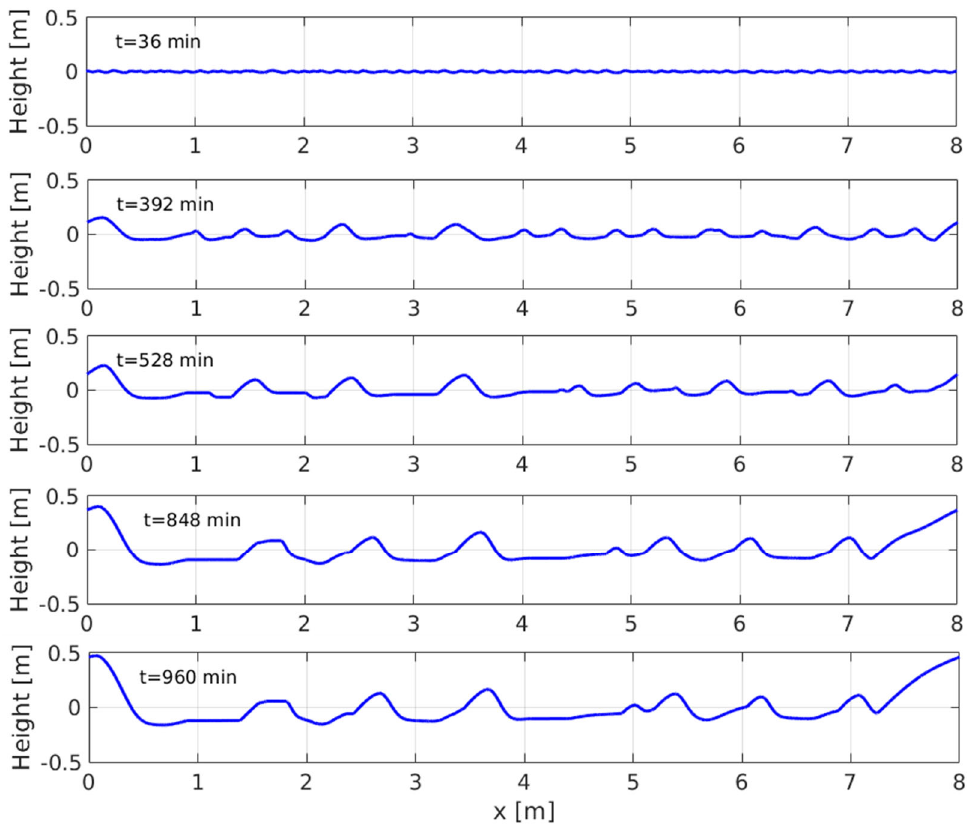
Figure 4. Evolution of ripples started from random initial condition for 100 μ m sand. The wind direction is from left to right and it is constant during the simulation.